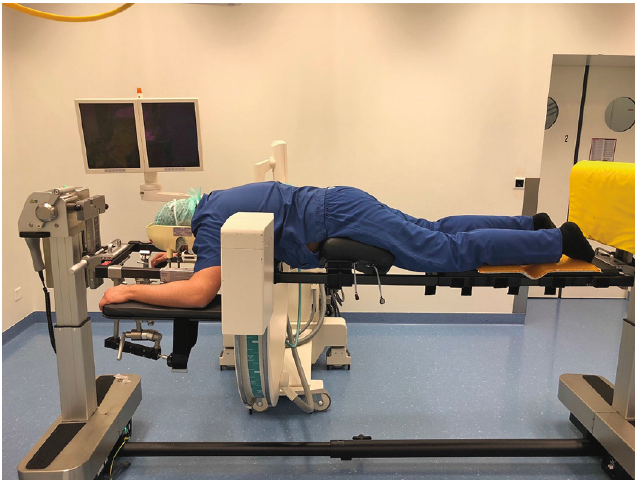
Figure 1: Radial nerve sustained a compression by the C-arm fl uoroscopy — global view.